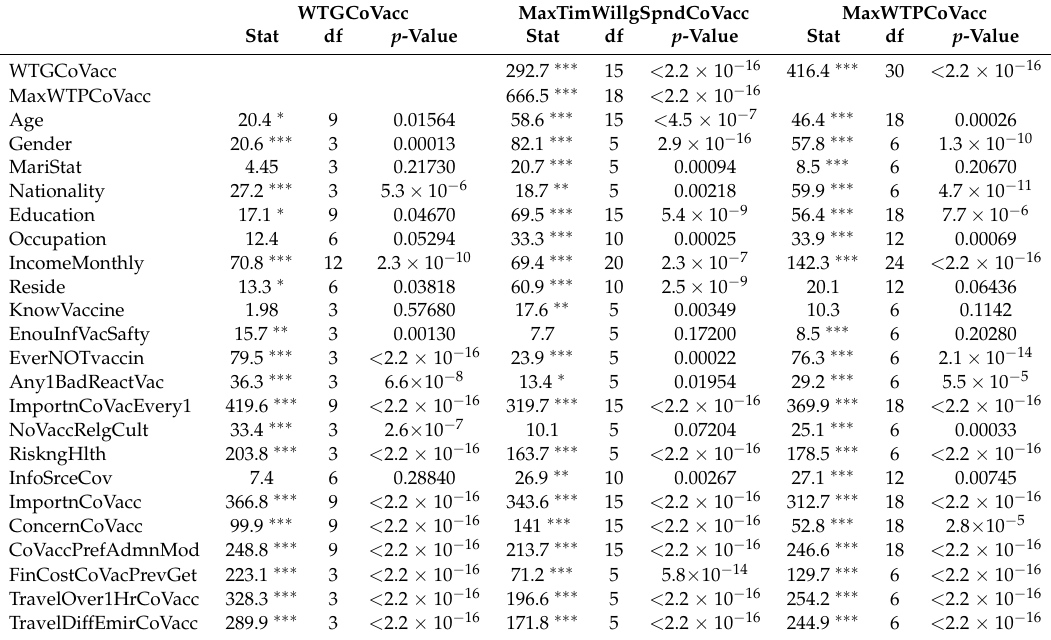
Table A5. Chi-square test results for the three outcome variables with the explanatory factors in the model.